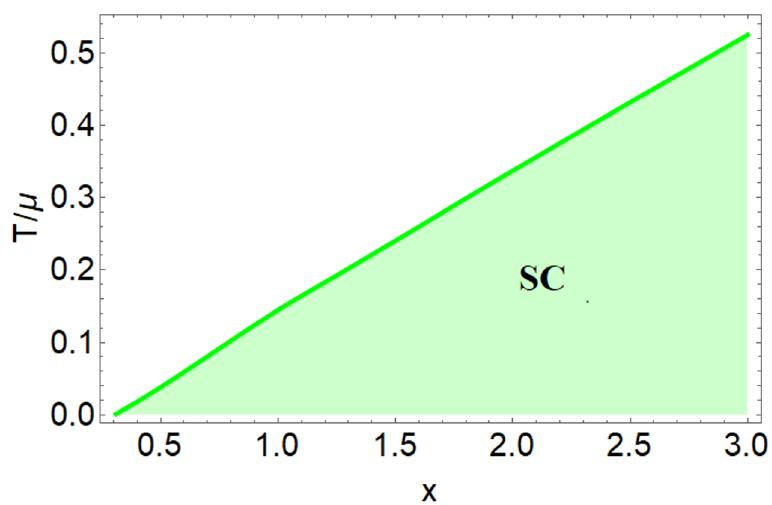
Figure 6 . The SC phase diagram in ( x , T )